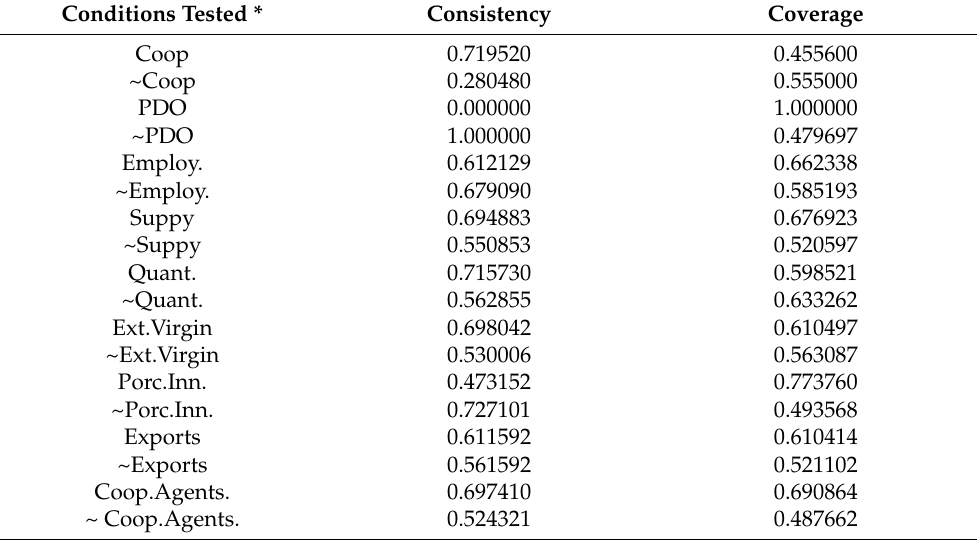
Table 3. Companies’ valuation of their involvement in eco-innovation. Analysis of necessary conditions.